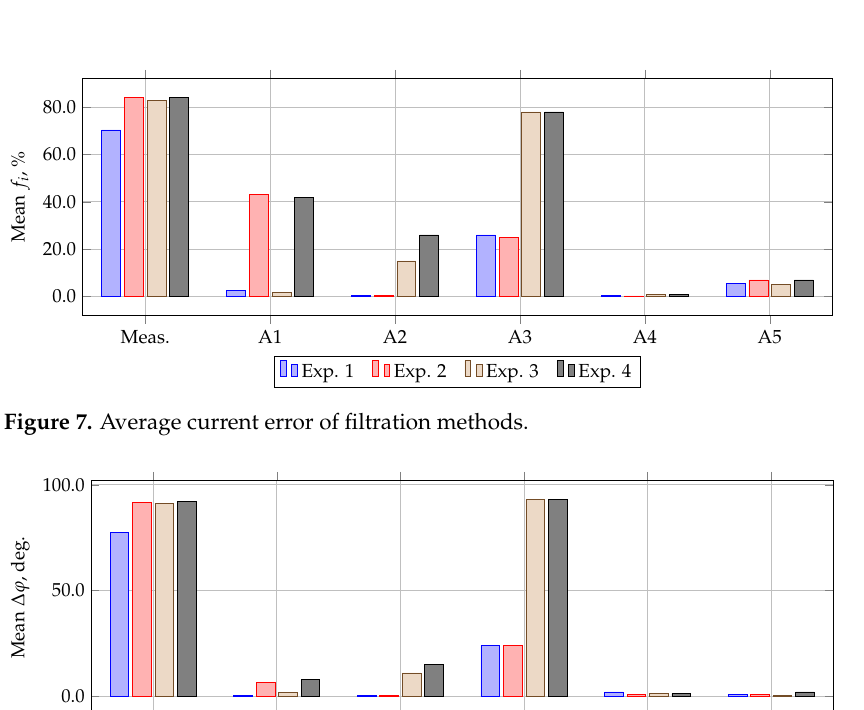
Meas. Figure 8. Average angular error of filtration methods Figure 8. Average angular error of filtration